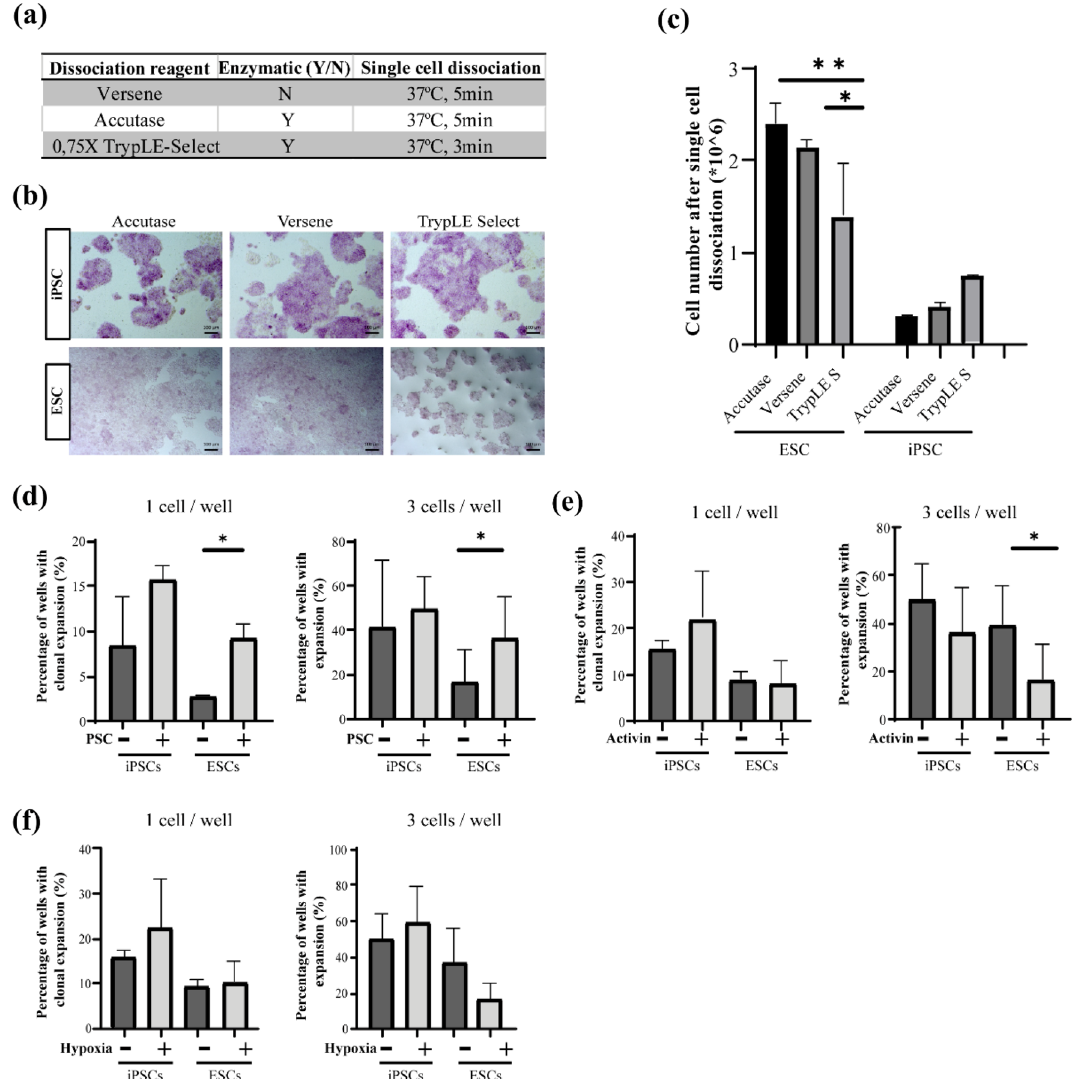
Figure 5. Clonal cell line derivation from rhesus macaque pluripotent stem cells. ( a ) Reagents and conditions tested for dissociation. ( b ) AP lkaline phosphata staining after single-cell dissociation and re-seeding of DPZ_iRhpb#4 and Rh_ESC (Scale bar 100 µm). ( c ) Cell numbers three days after single-cell dissociation of 2 × 10 5 cells (n = 4) (Mean ± SD). ( d – f ) Percentage of cells (iRhpb#4 and Rh_ESC) achieving clonal expansion after dissociation and sorting in 96 well plates. Left graph, clonal expansion after sorting one cell per well. Right graph, colony expansion after sorting three cells per well (Mean ± SD). ( d ) Cells sorted in standard UPPS medium (Control) and in UPPS medium supplemented with 10 µM pro-survival compound (+ PSC). ( e ) Percentage of wells with clonal expansion of cells sorted in UPPS + PSC (Control) vs. cells sorted in UPPS + PSF + Activin (50 ng/µl). ( f ) Clonal expansion of cells sorted in UPPS + 10 µM PSC in normoxia and hypoxia (5% O 2 ). (*) p < 0.05, (**) p < sequencing (data not shown) and T7 endonuclease I assay 35 in order to gain insights into the functionality of the gRNAs plus vector before starting the laborious single-cell cloning process (Supplementary Fig. 10). Both gRNAs showed evidence of on-target editing activity (Supplementary Fig. 10). While the targeted site encoding the N-terminal sequence showed only faint digestion products in the T7 endonuclease I assay, the targeted site encoding the C-terminal sequence showed more intense bands. After transfection and expansion of the trans- fected cells, the single-cell cloning protocol developed above was followed, and monoclonal lines containing frameshift mutations ( fxs ) in both loci were expanded. Eight clones with truncating N-terminal mutations were obtained: three for Rh_ESC and five for DPZ_iRhpb#4. Mutations in the different clones were analyzed by PCR amplification of the targeted genomic loci and subsequent sequencing of the products (data not shown). The effi- ciency of the process was also analysed for the C-terminus, and independent biological replicas for each cell line were performed (transfection, sorting, and expansion). For the C-terminal mutation, 37 mutated clones were obtained from 42 clones analyzed in total (DPZ_iRhpb#4: 27 mutated/28 analyzed; Rh_ESC: 10 mutated/14